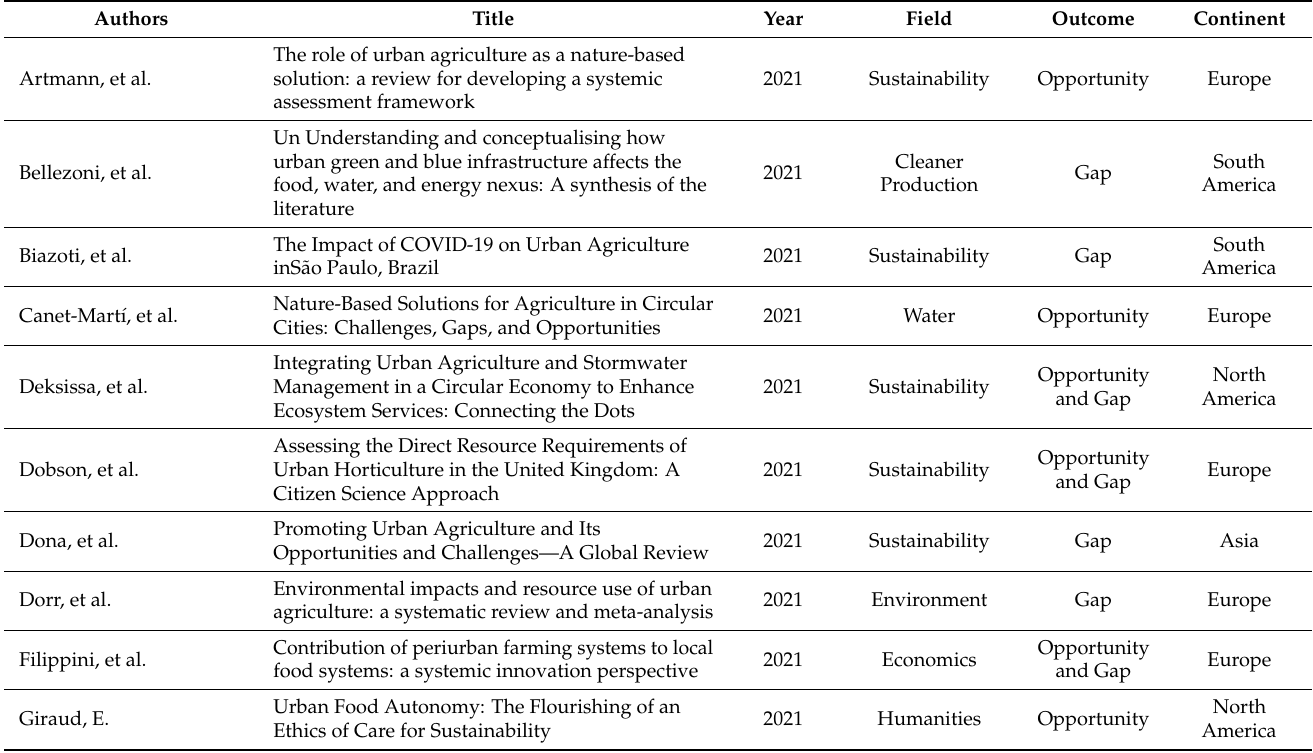
Table 2. Publications selected for systematic literature review and outcomes